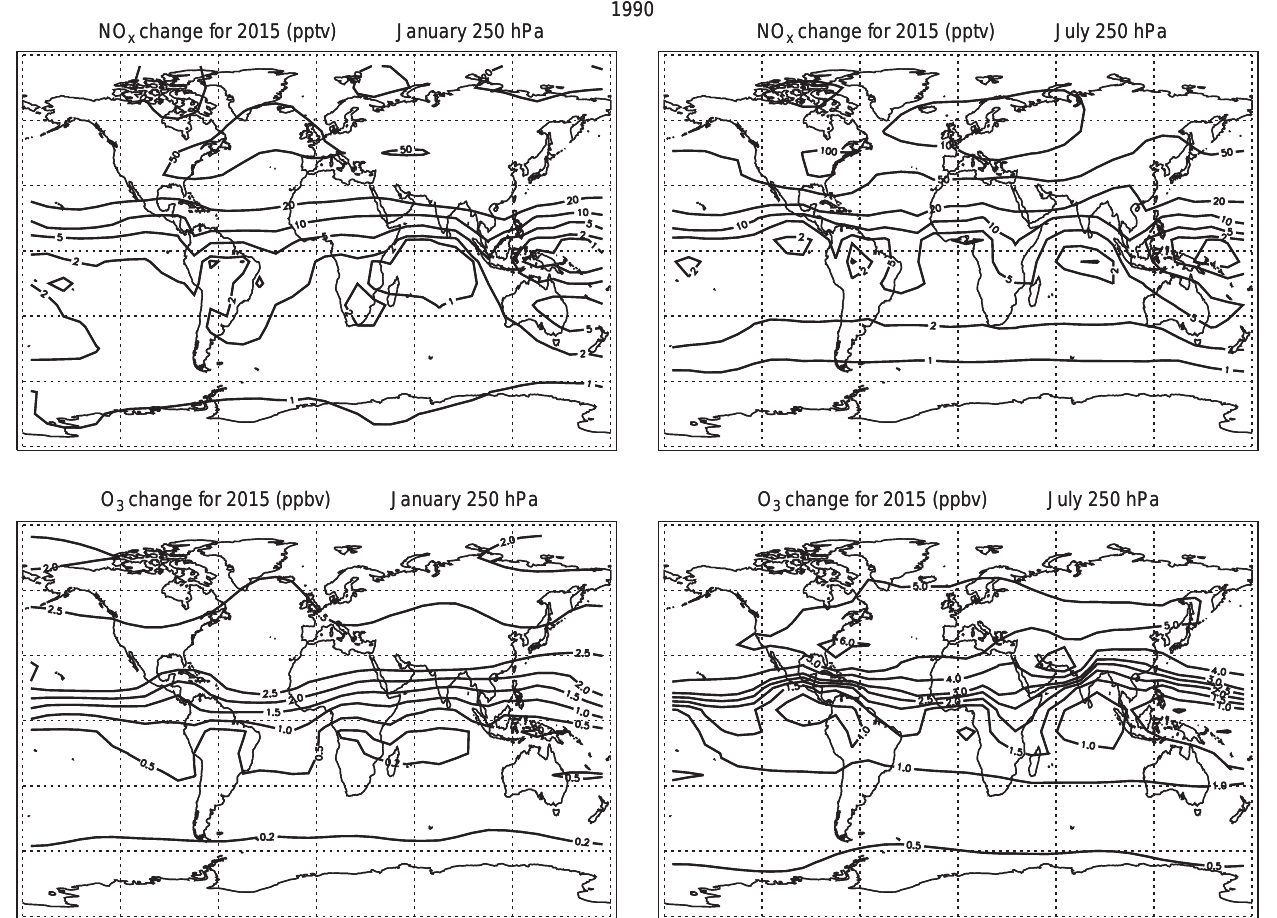
Fig. 5. Distribution of the NO